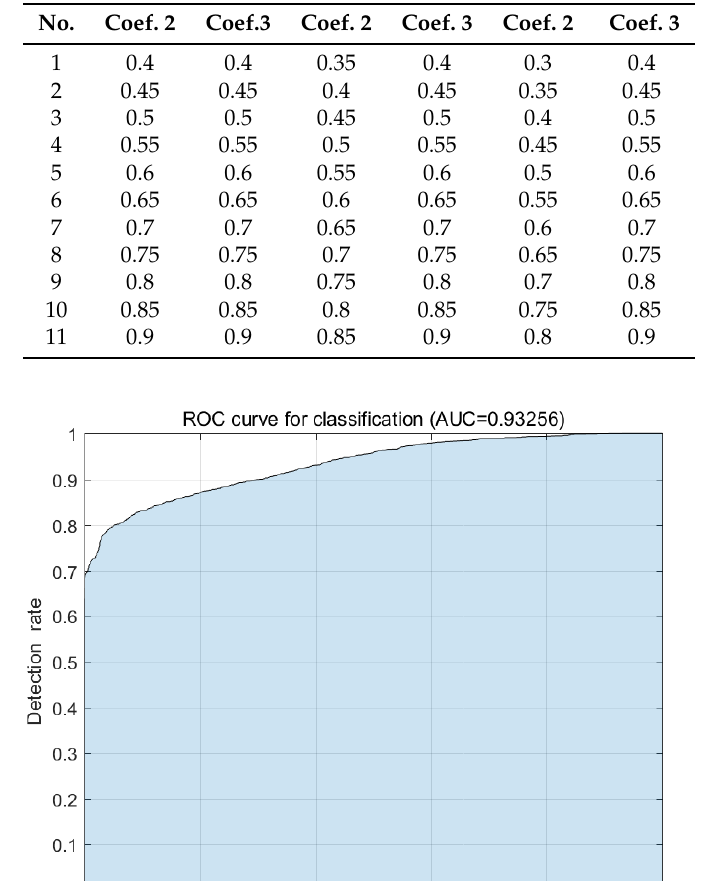
Table 3. List of the coefficients employed to generate the simulated target signals.